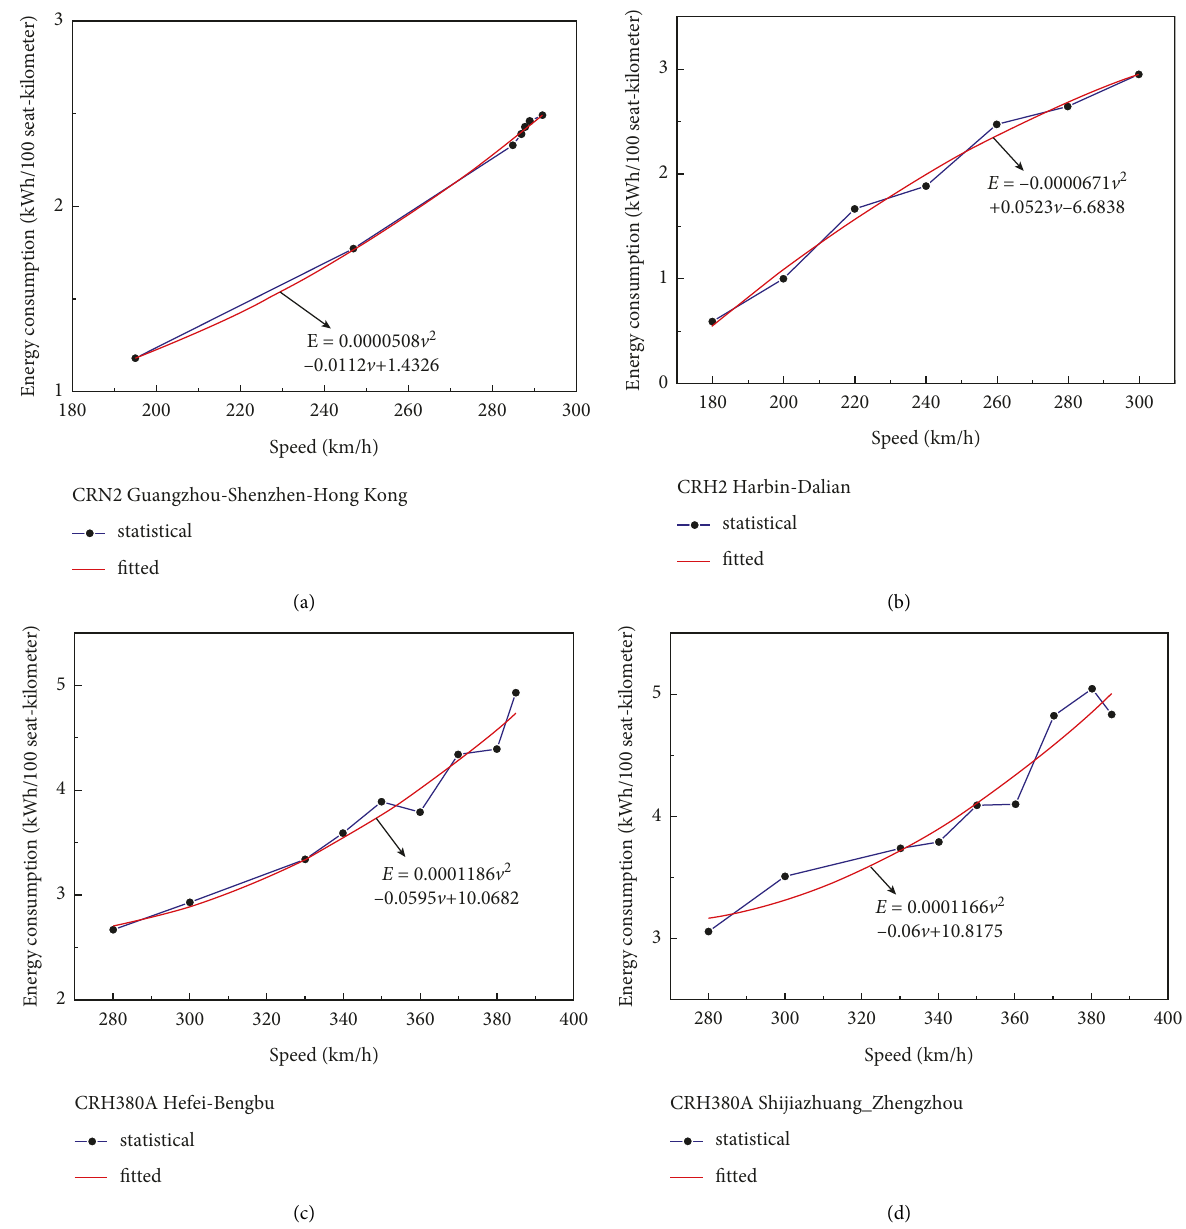
Figure 1: Statistical values of energy consumption and calculated values by fitting equations at different speed levels of CRH2 and CRH380A